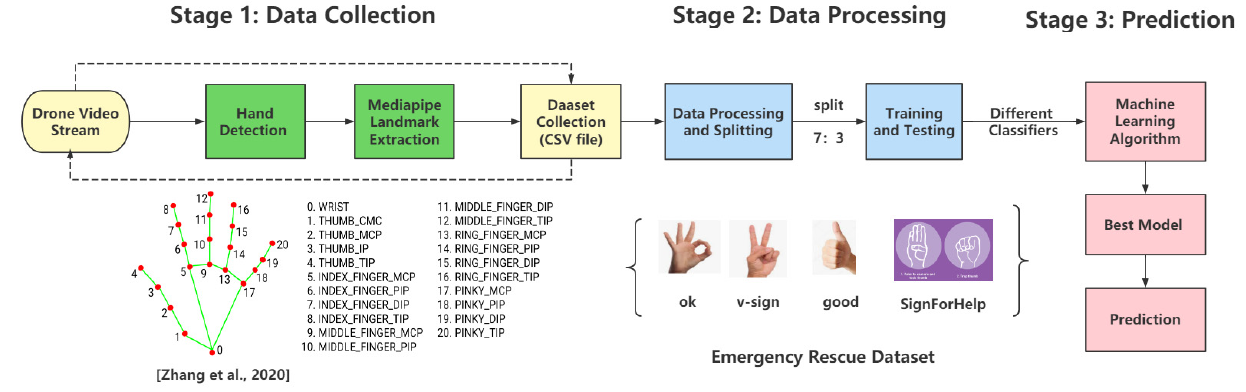
Figure 6. Architecture of the emergency rescue recognition method [64].